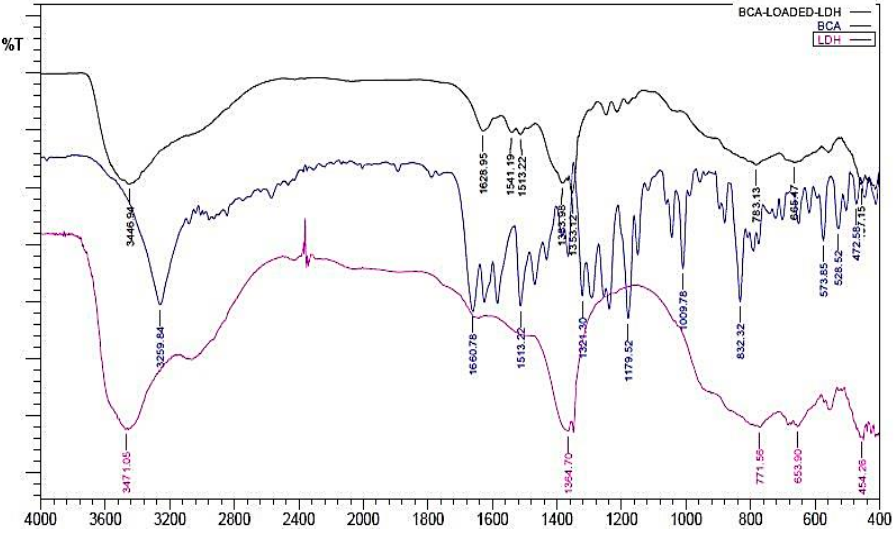
Figure 3. Overlay of FTIR of BCA-LDH-C, BCA, and LDH.